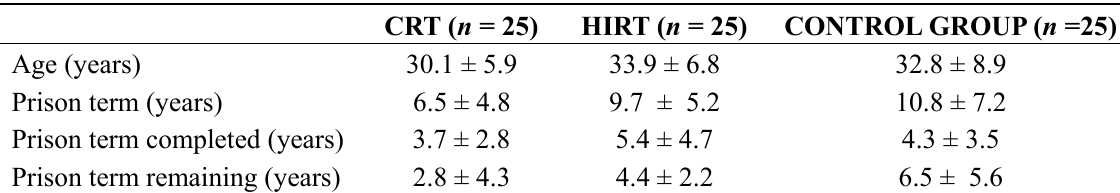
Table 1. Sample characteristics (mean ± SD).